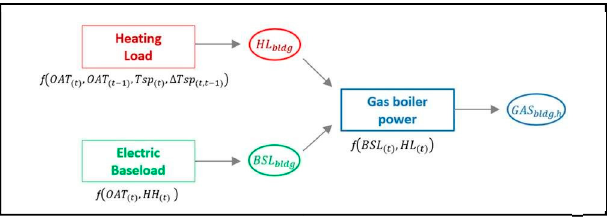
Figure 3. Schematic of the proposed model